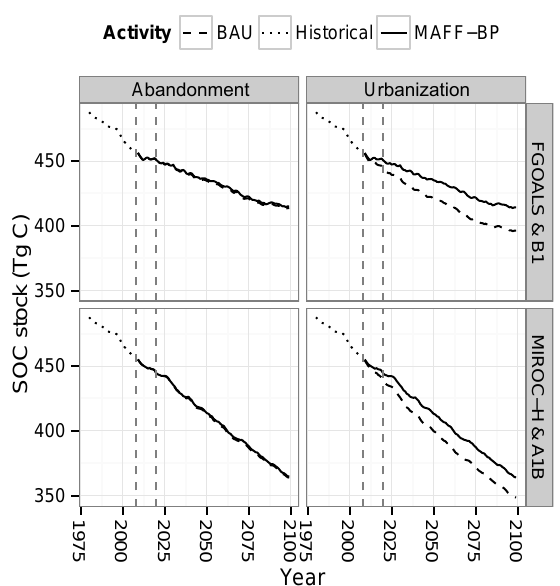
Figure 6. Simulation output on the changes in total soil organic carbon (SOC) stocks in agricultural lands in Japan under differ- ent future agricultural scenarios (BAU and MAFF-BP; indicated by different line type), future land-use change (abandonment and urbanization; lined up horizontally), and future climate projection (FGOALS & B1 and MIROC-H & A1B; lined up vertically), in periods including historical (1970–2006), future scenarios during 2007–2020 with varying input rate toward target or predicted levels in 2020, and subsequent future period in 2021–2099 with assuming no change in input rate after 2020. Vertical dashed line on the left and right indicate 2006 and 2020,